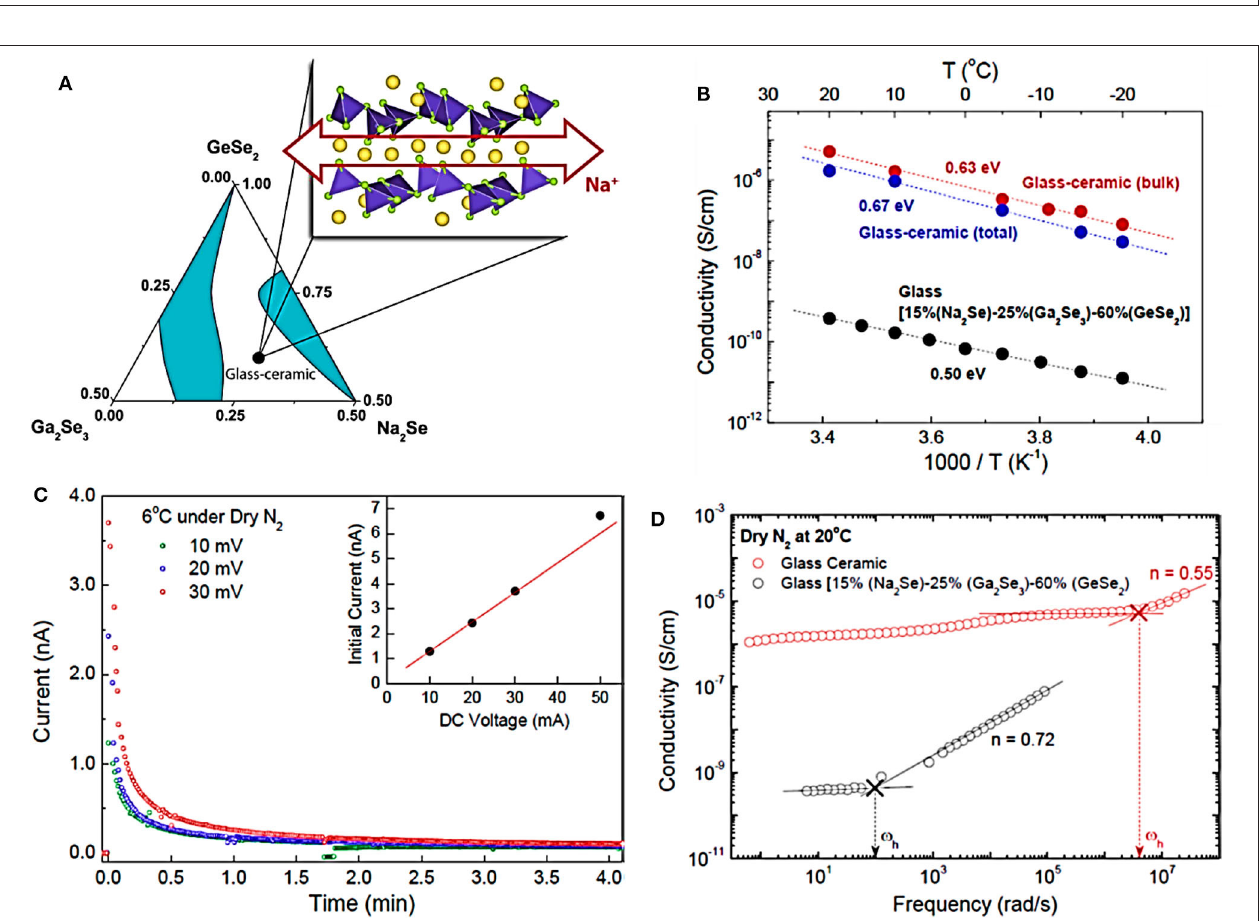
FIGURE 1 | band center (source: Krauskopf et al., 2018a). Reproduced by permission of American Chemical Society https://doi.org/10.1021/jacs.8b09340 Crystal structure of (k) c-Na 3 PS 4 and (l) t-Na 3 PS 4 . (m) Experimental G(r) data for HT-t-Na 3 PS 4 and BM-c-Na 3 PS 4 . (n) Rietveld refinements of XRD for (BM)-c-Na 3 PS 4 and HT-t-Na 3 PS 4 . (o) Nyquist plots of t-Na 3 PS 4 and c-Na 3 PS 4 at different synthetic approaches. (p) Arrhenius plots of all compounds. (q) Activation energy and room-temperature ionic conductivity for different types of Na 3 PS 4 (source Krauskopf et al., 2018a). Reproduced by permission of American Chemical Society https:// doi.org/10.1021/acs.inorgchem.8b00458.